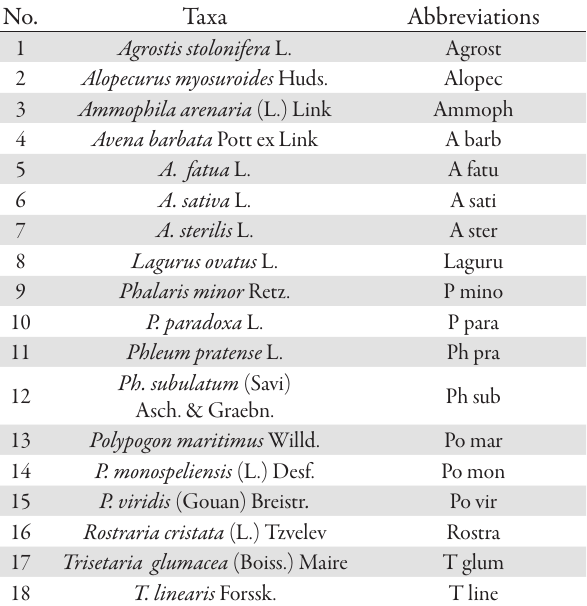
Tab. 2. The taxon sample and taxa abbreviations used in the numerical analysis of tribe Aveneae , Poeaceae (According to